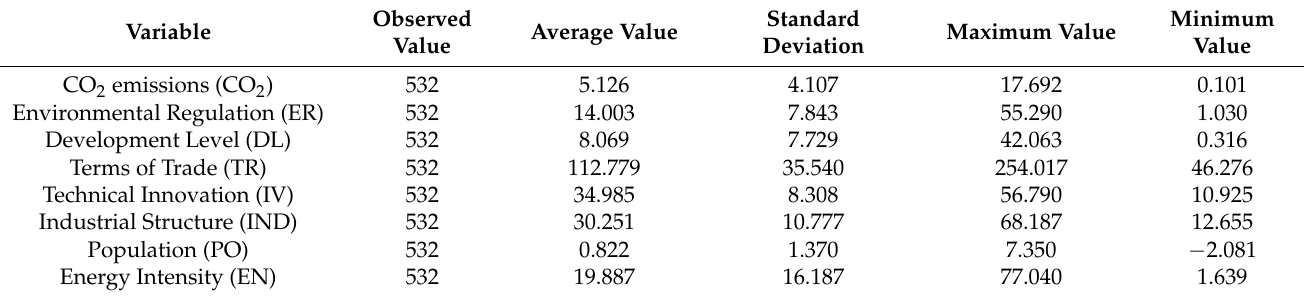
Table 2. Statistical descriptions of variables.